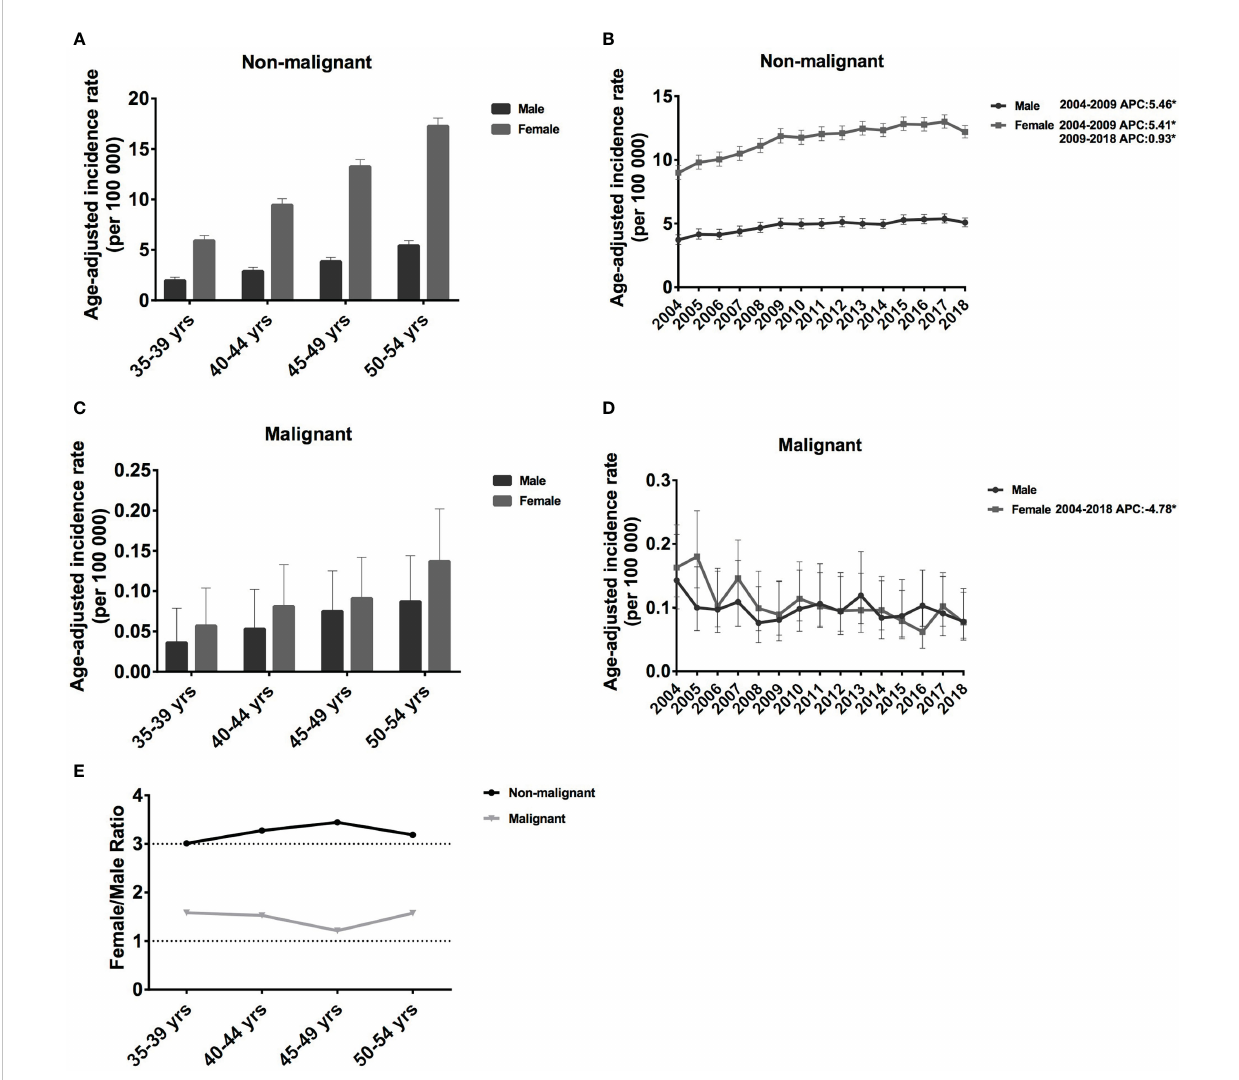
FIGURE 1 Age-adjusted incidence rates (IRs) and annual percent changes (APCs) by age and sex. IRs by sex and by 5-year age intervals (A, C) , APCs by sex over time from 2004 – 2018 (B, D) . (A, B) , non-malignant meningioma; (C, D) , malignant meningioma; (E) , the female to male ratio curve of the IRs by age. *Only show APCs that are signi fi cantly different at the P < 0.05